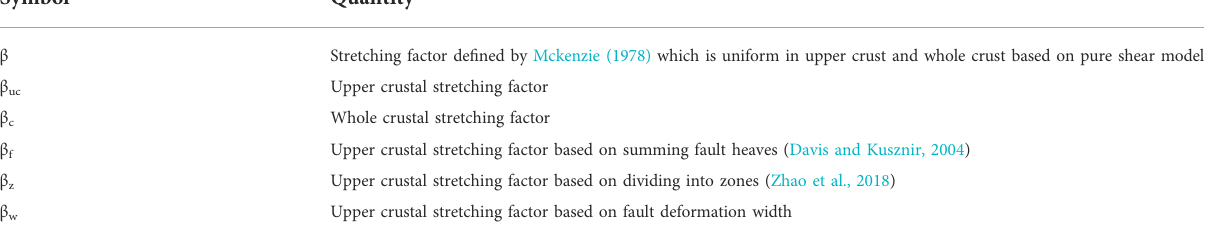
TABLE 1 Stretching factors related to this study. Symbol